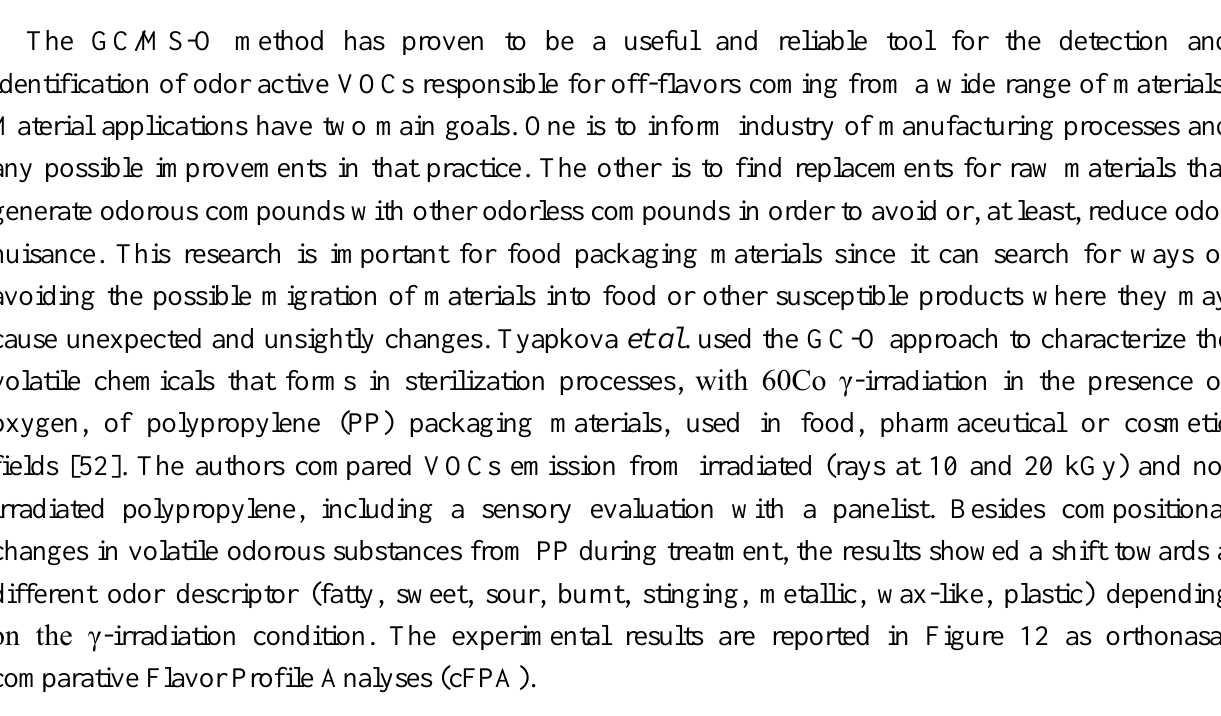
Figure 12. Orthonasal comparative flavor profile analysis (cFPA) of three powdered PP samples. The data are displayed as mean numerical values of the sensory evaluations (three sessions with six panelists each) (Reprinted from [52] with permission from